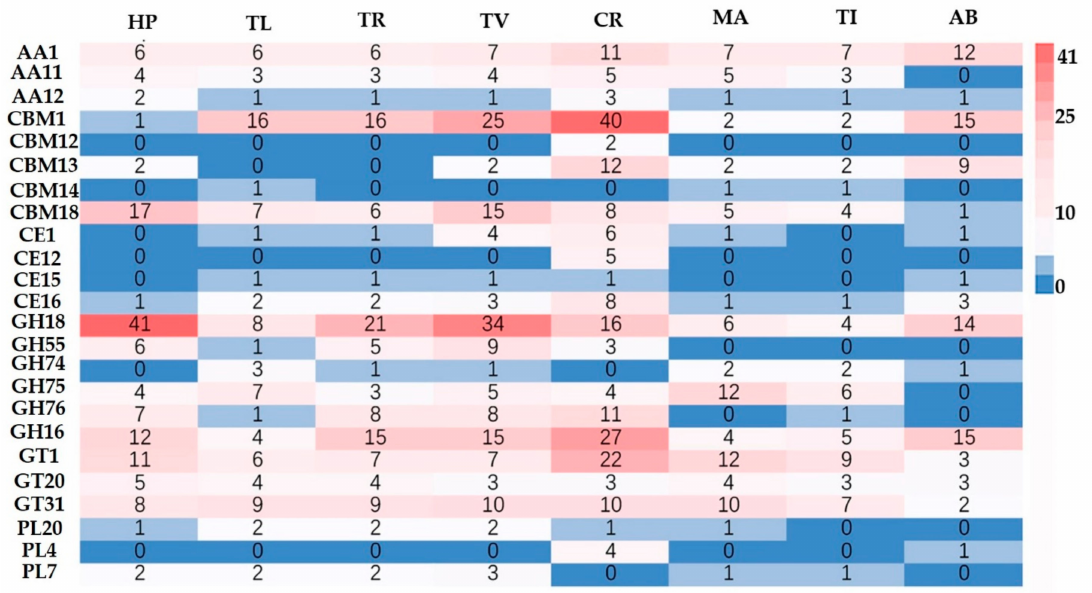
Figure 4. CAZyme richness of di ff erent fungi with di ff erent lifestyles (HP, TL, TV, and CR, mycoparasitic; AB ( A. bisporus ) and TR, saprotrophic; MA and TI,